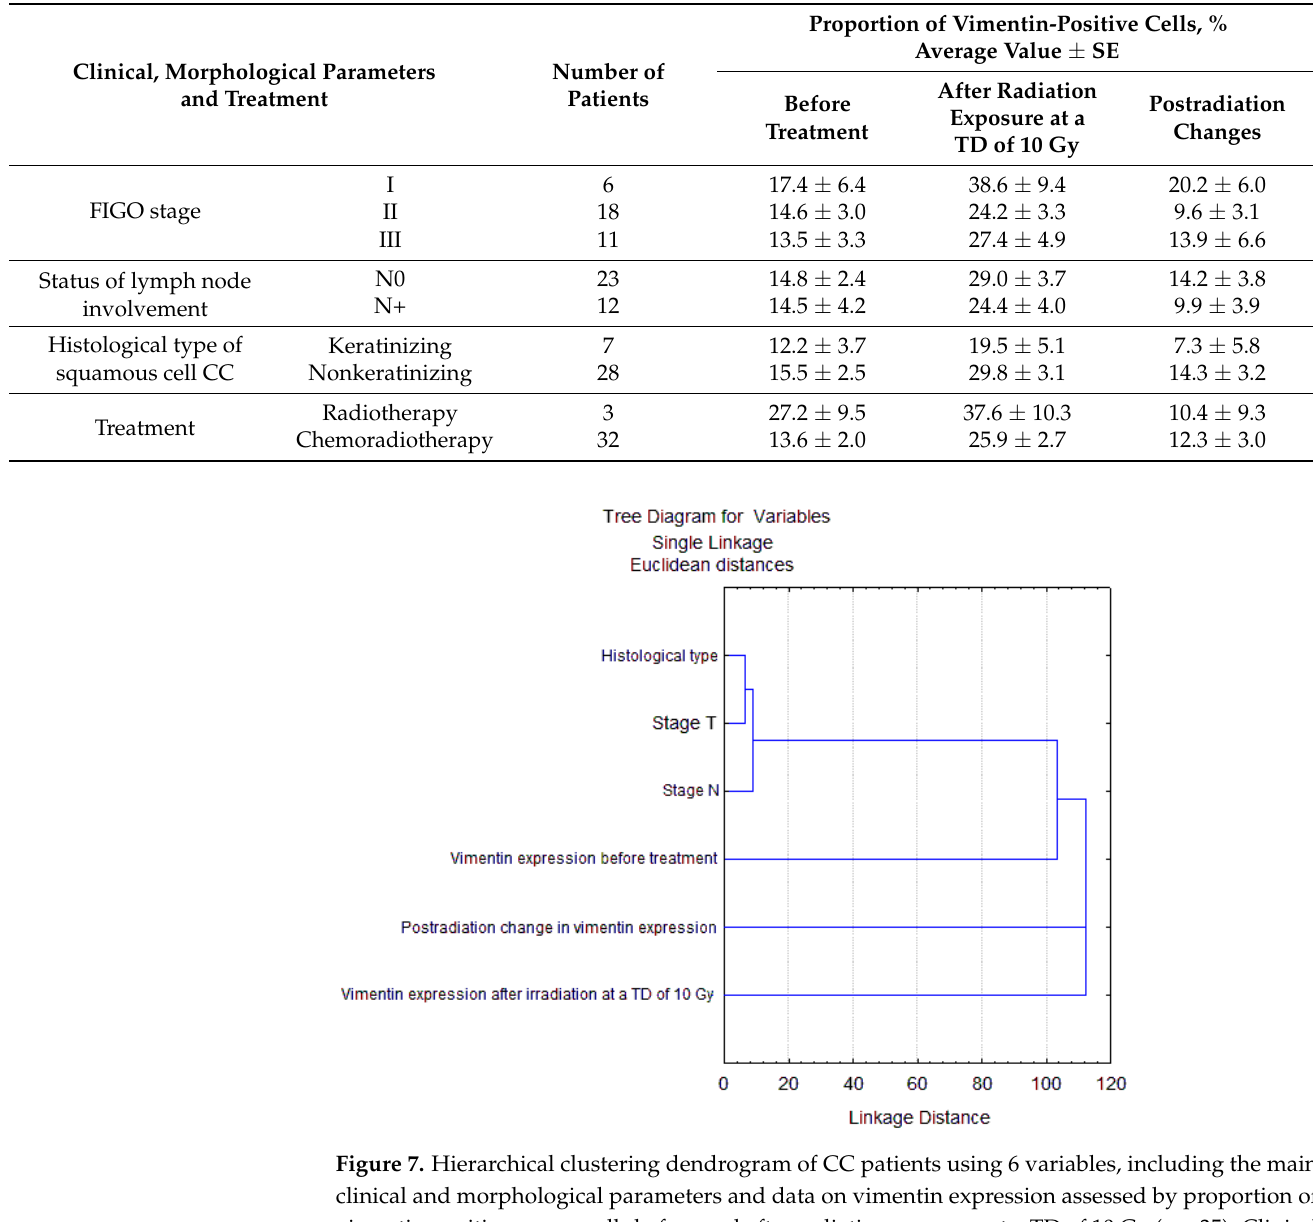
Table 1. Comparison of the proportion of vimentin-positive cancer cells with different clinical and morphological parameters of disease and treatment.